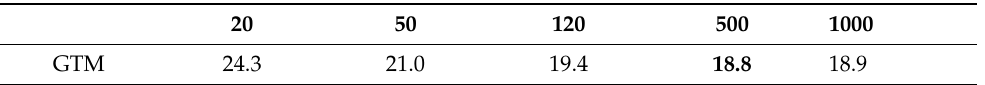
Table A5. Experiment 1: Impact on GTM tree error (FN) rates of varying the maximum subset size on the Cox1-HET datasets. The most accurate result is